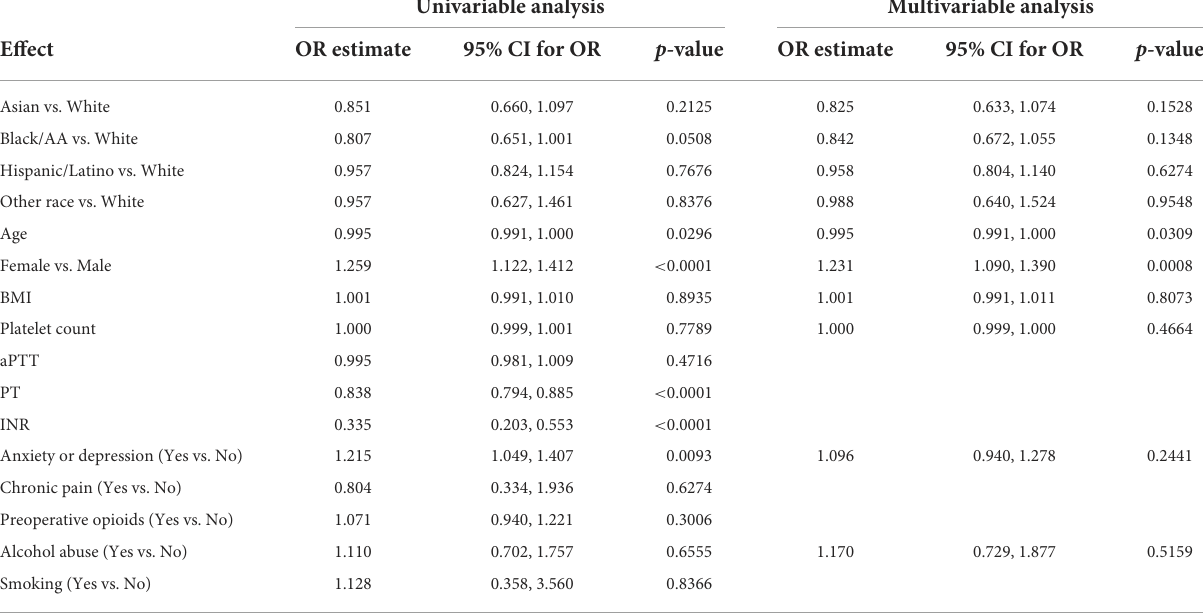
TABLE 2 Association between baseline patient characteristics and the use of regional anesthesia. Univariable analysis Multivariable